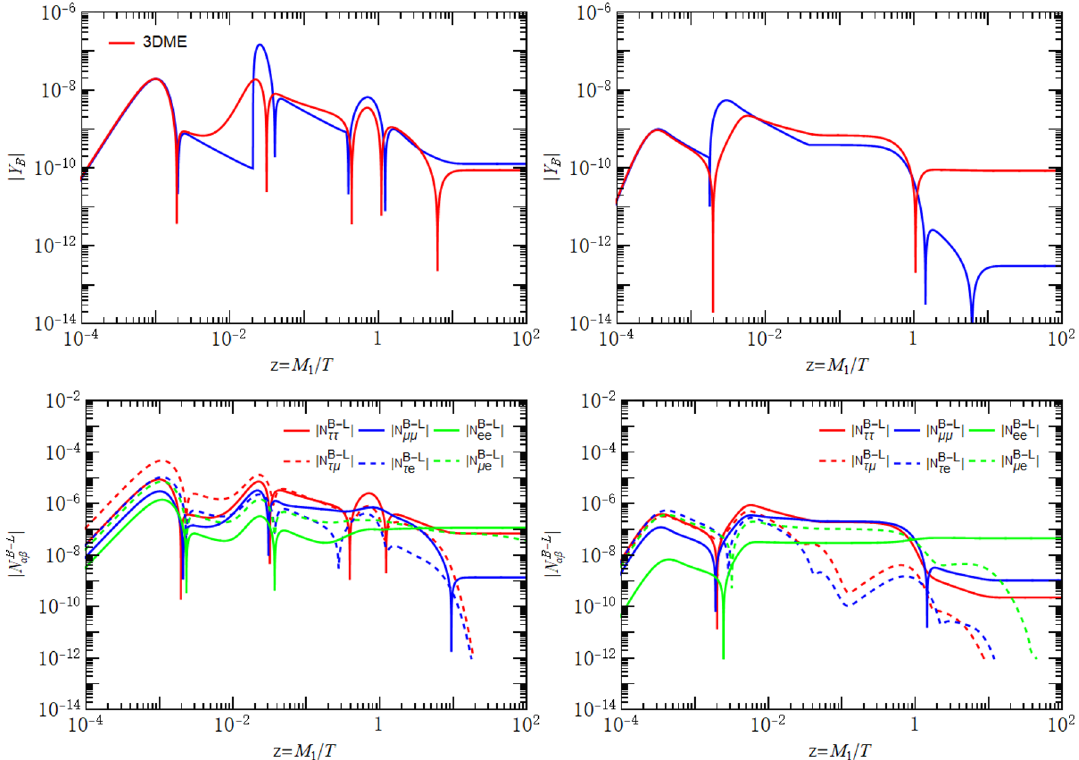
Figure 10 . The evolution of the baryon asymmetry Y B with temperature for the local minimum shown in table 5. The left and right panels are the BM1 with vanishing initial abundance and the BM2 with thermal initial abundance respectively. The evolution of the B − L asymmetry number densities N B − L , α, β = e, µ, τ displayed in the lower panel is described by the density matrix αβ equations in eq.